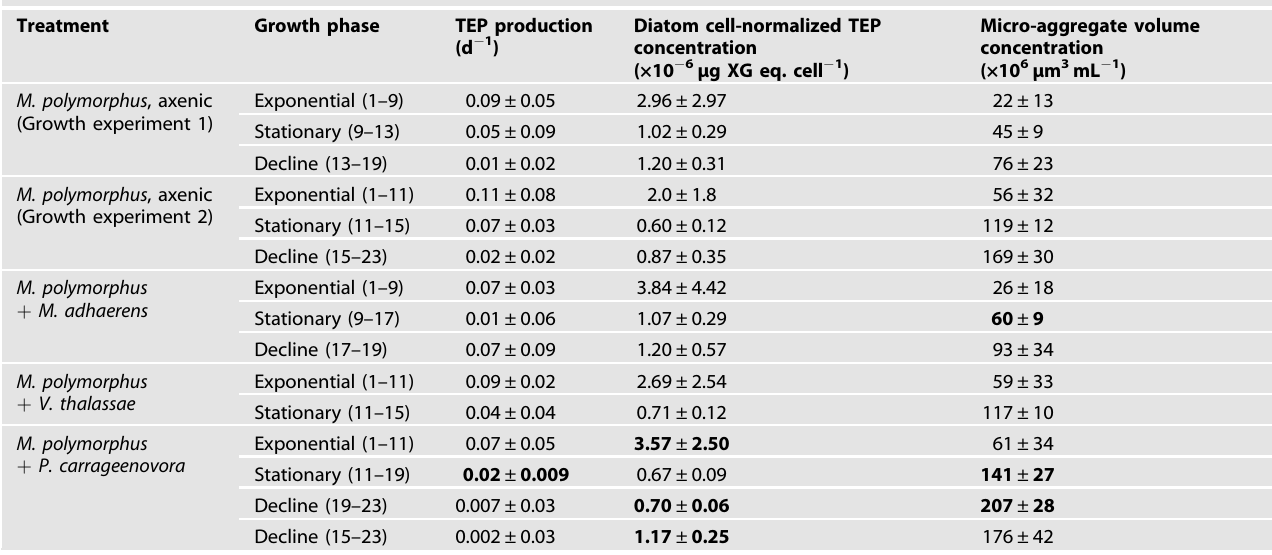
Table 2. Transparent exopolymeric particle (TEP) production, TEP concentration normalized to diatom cell abundance, and volume of suspended micro-aggregates during the exponential, stationary, and decline growth phases of Minutocellus polymorphus in axenic cultures and in co-cultures with Marinobacter adhaerens HP15, Vibrio thalassae , or Pseudoalteromonas carrageenovora . Transparent exopolymeric particle production and micro-aggregate formation